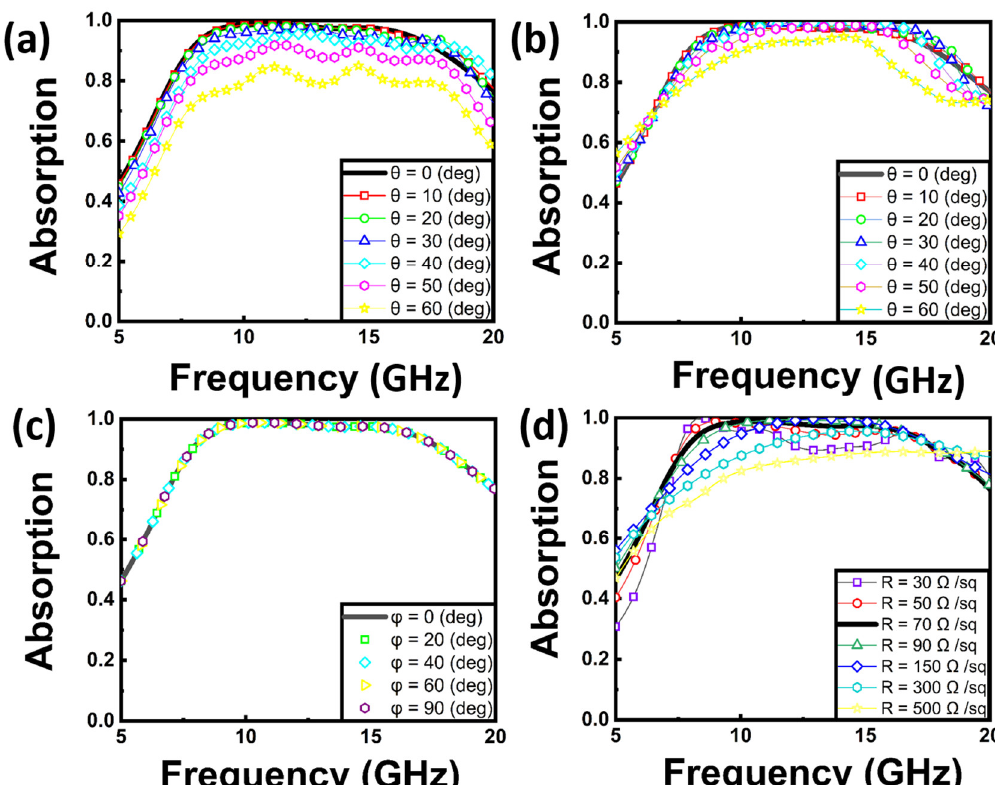
Figure 5. Simulated absorption results for the obliquely-incident angles of ( a ) TE- and ( b ) TM-polarized incident wave, according to ( c ) polarization angle and ( d ) resistance of the conductive-graphene ink sheet.